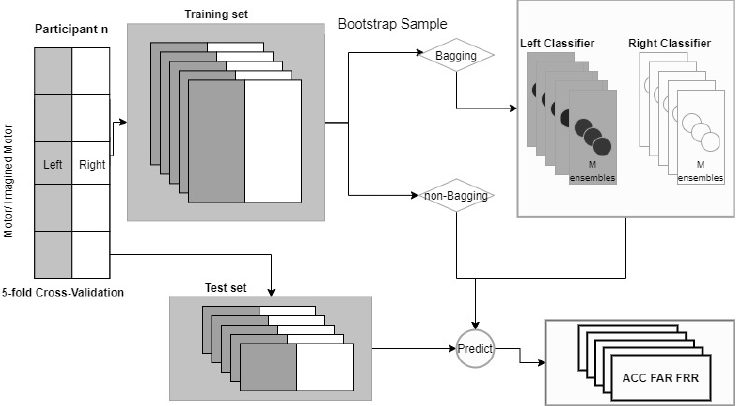
Figure 5. Overall workflow of the bagging